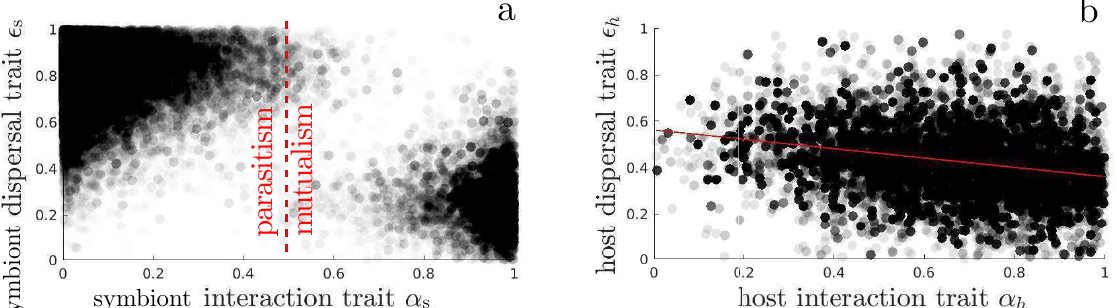
Figure 3. Post transition traits distribution ( ε, α ) of symbionts (panel a) and hosts (panel b). The dashed red line in panel a indicates the threshold α ∗ s = 0 . 475 above which a symbiont benefits its host. The plain red line in panel b shows the linear regression between host traits (R simulations with strong competition γ C = 0 . 2 , no dispersal cost d = 0 and with a maximum projection time 4 of 10 steps. Other parameters are m = 0 . 06 , c m = 0 . 3 , w h = 1 , f and β max = 0 . 5